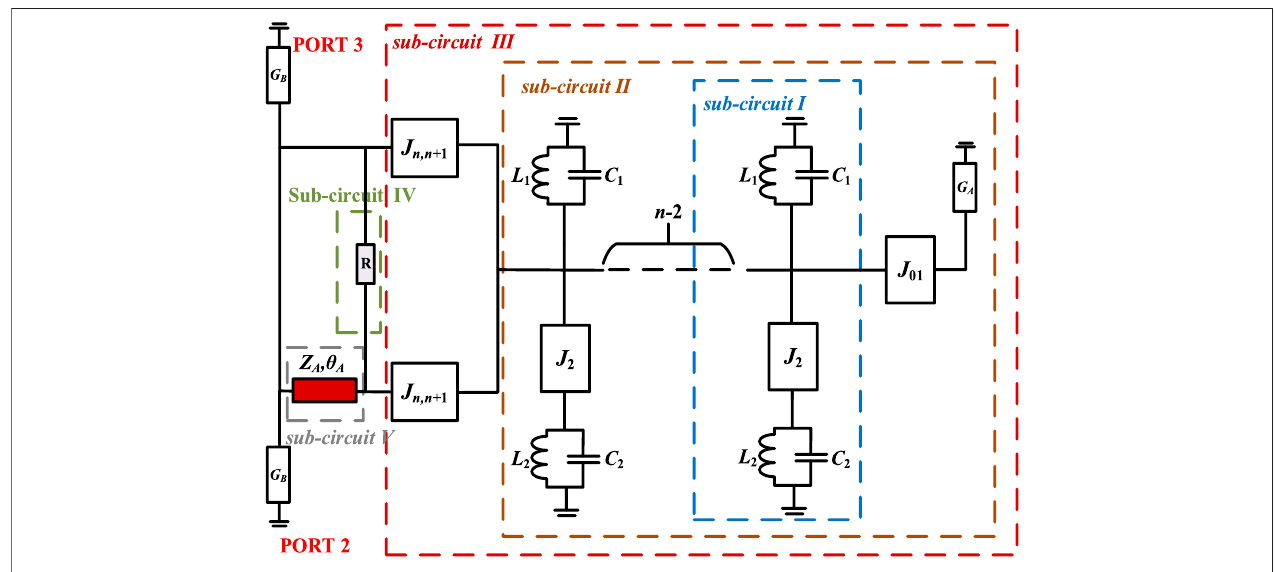
FIGURE 3 | Equivalent circuit diagram for analyzing isolation between two output